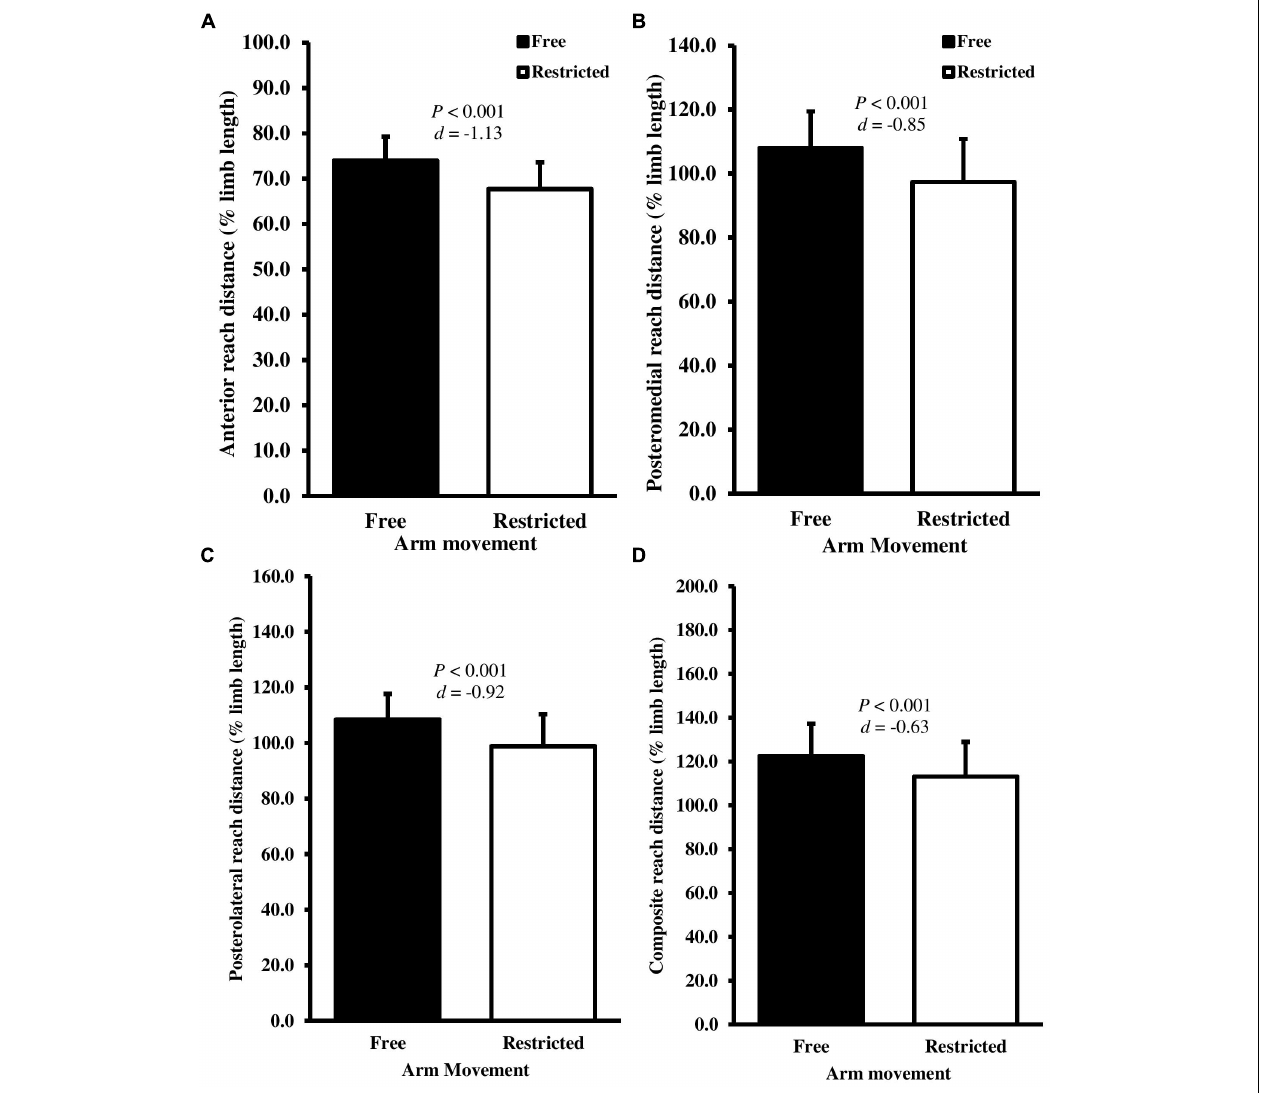
FIGURE 2 | Mean ± SD normalized (A) anterior, (B) posteromedial, (C) posterolateral, and (D) composite reach distance for the Y Balance test with free (black bars) and restricted (white bars) arm movements. d -Value represents Cohen’s d effect